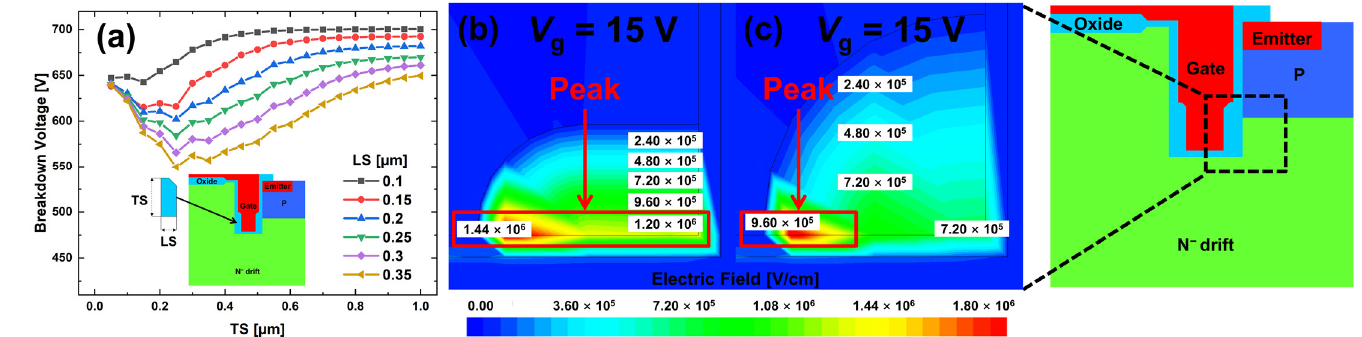
Figure 5. ( a ) Breakdown voltage according to the sidewall spacer parameters. Electric field distribution when ( b ) TS = 0.1 µm and ( c ) TS = 0.2 µm, when each LS = 0.2 µm.